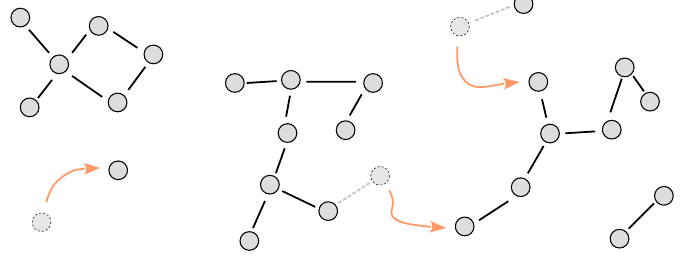
Figure 1. Opportunistic networking in a disconnected mobile